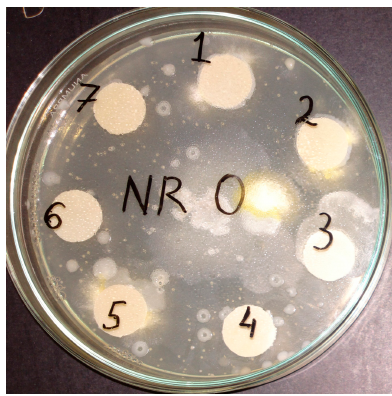
Figure 1. Seven disks of control sample (free natural fibers) placed in Petri dish (15 cm diameter), containing Sabouraud Dextrose Agar medium.